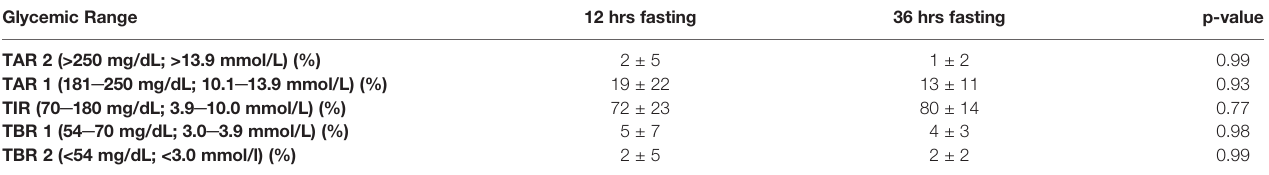
TAR 2, time above range 2; TAR 1, time above range 1; TIR, time in range; TBR 1, time below range 1; TBR 2, time below range 2 (n=20).